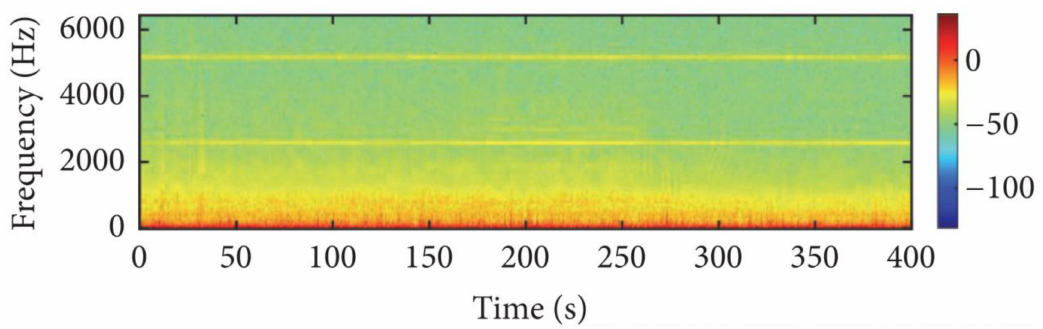
Figure 5. A frequency domain diagram of underwater noise.